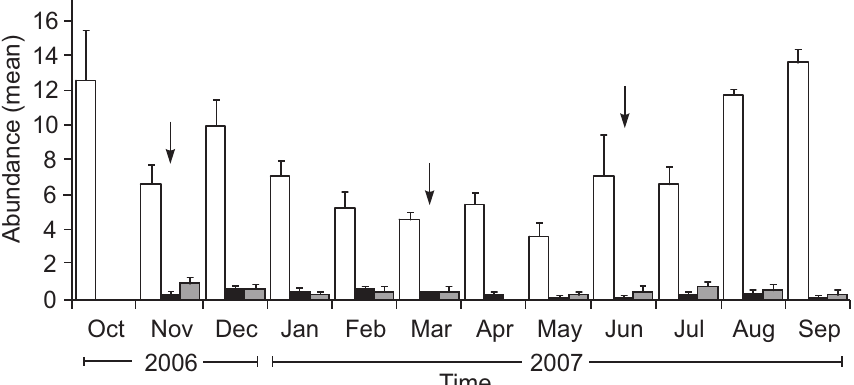
Figure 2. Abundance (mean ± SD) of males (white bars), females (black bars), juveniles (gray bars) and egg clutches (arrows) of Hypsiboas leptolineatus , recorded from October 2006 to September